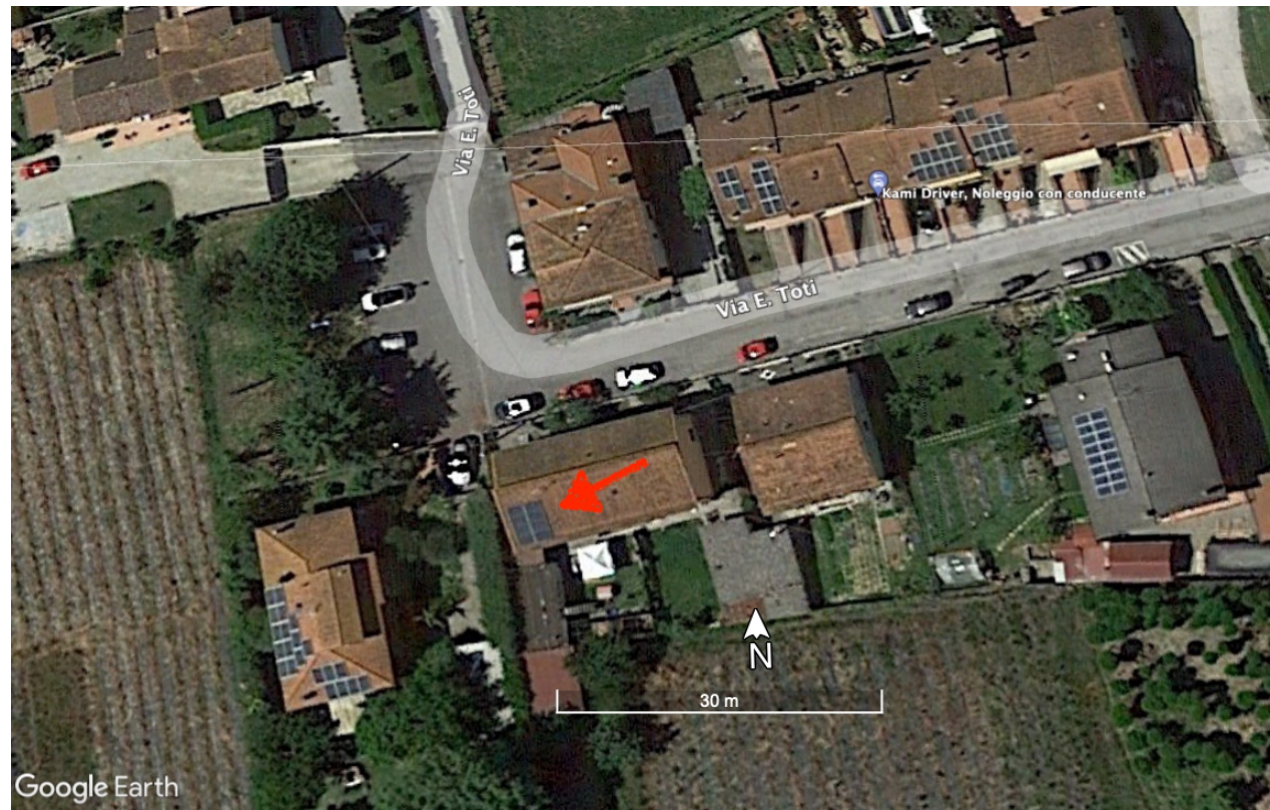
Figure 2. The red arrow indicates the photovoltaic modules (43.51 ◦ N, 10.48 ◦ E, 20 m a.s.l.) used in this study. The panel azimuth angle is 163 ◦ azimuth and it is tilted by 30 ◦ degrees. Image: Google Earth Pro (7.3.3.7786, 4 June